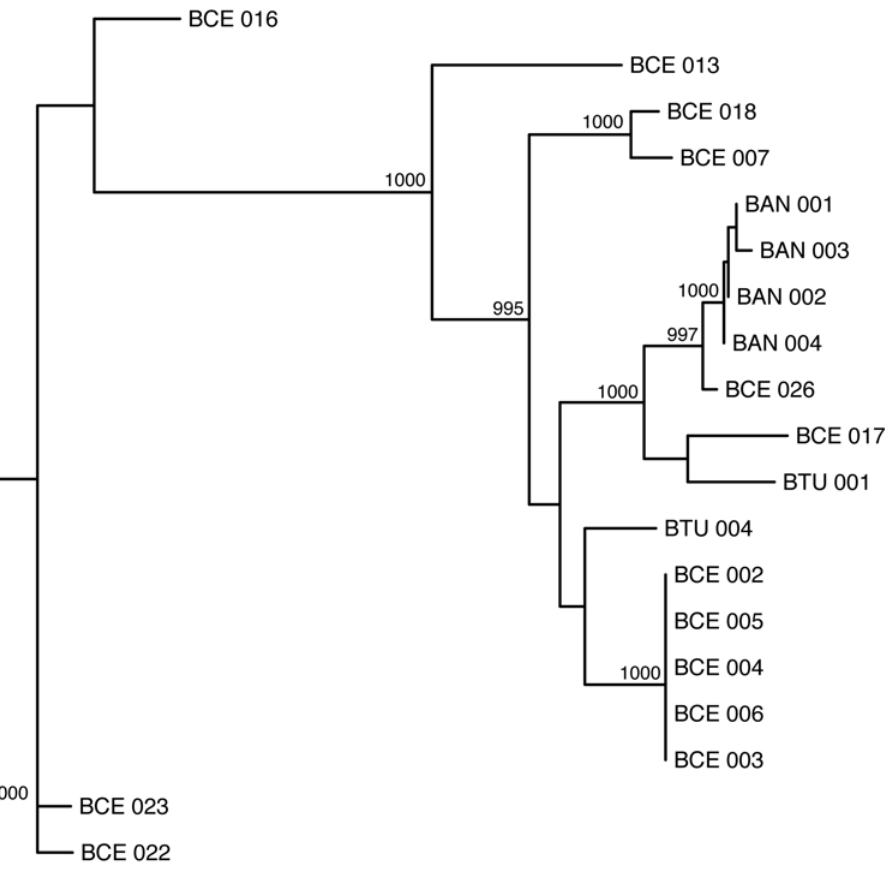
Figure 4. Neighbor-joining phylogenetic tree inferred using multilocus sequence typing (MLST) data for a subsample of 19 Bacillus strains. Bootstrap values for nodes with greater than 99% support (1000 replicates total) are shown.